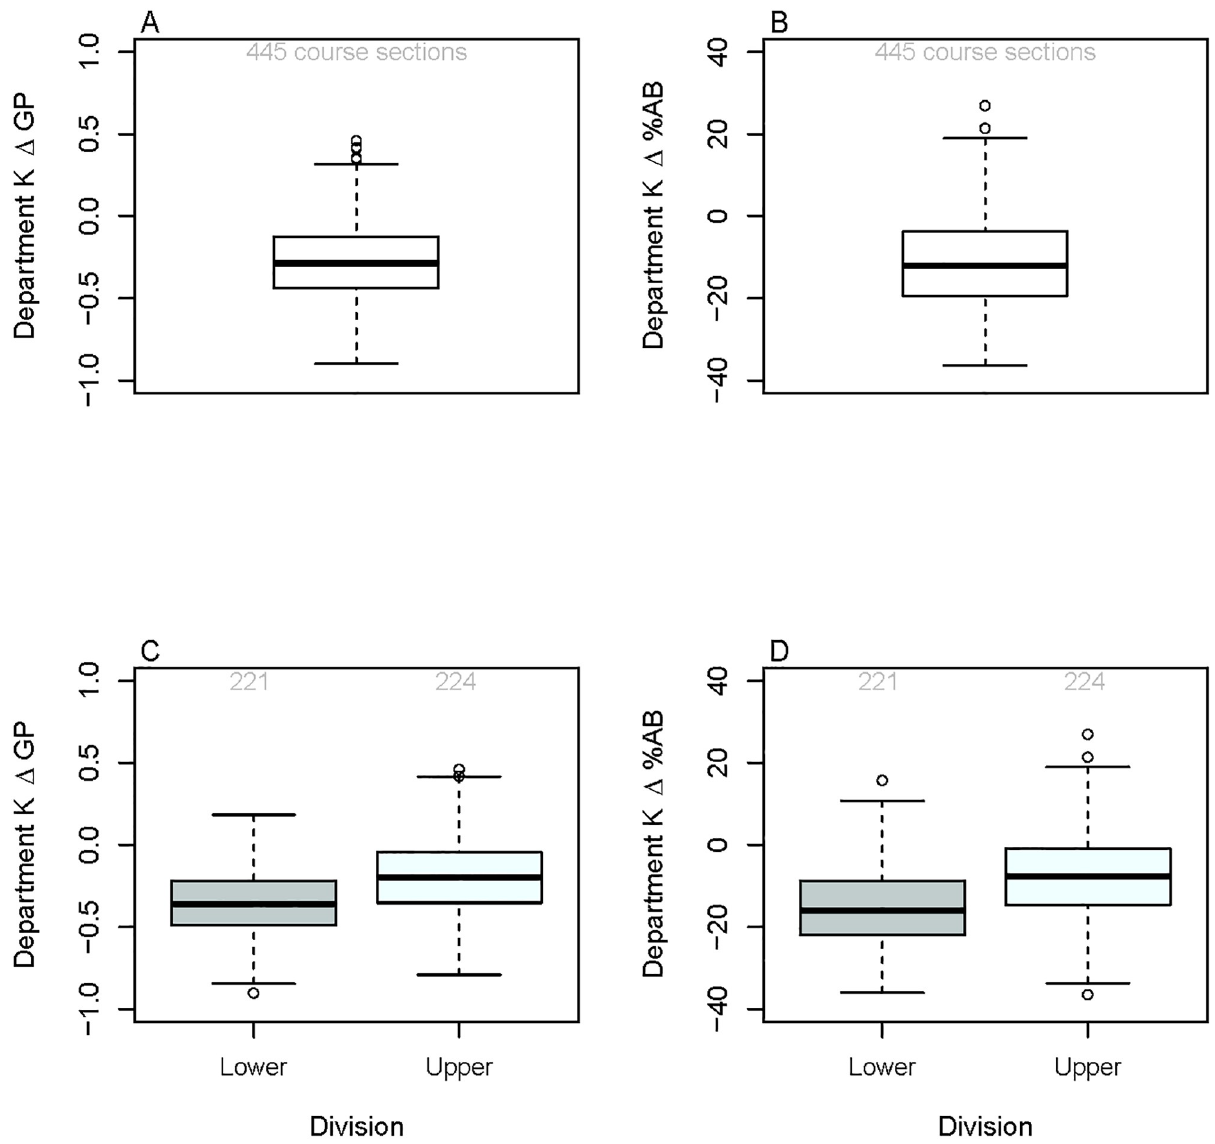
Fig 2. Boxplot of Δ GP and Δ %AB per course section for Department K . (A) and (B) combine the information from all course sections whereas (C) and (D) separate the course sections by level (lower versus upper division). A total of 445 course sections are displayed consisting of 74 unique courses, 189 unique instructors, and 217 unique course-instructor pairs. The 221 lower-division course sections had 24 unique courses, 96 unique instructors, and 107 unique course-instructor pairs. The 224 upper-division course sections had 50 unique courses, 102 unique instructors, and 110 unique course- instructor